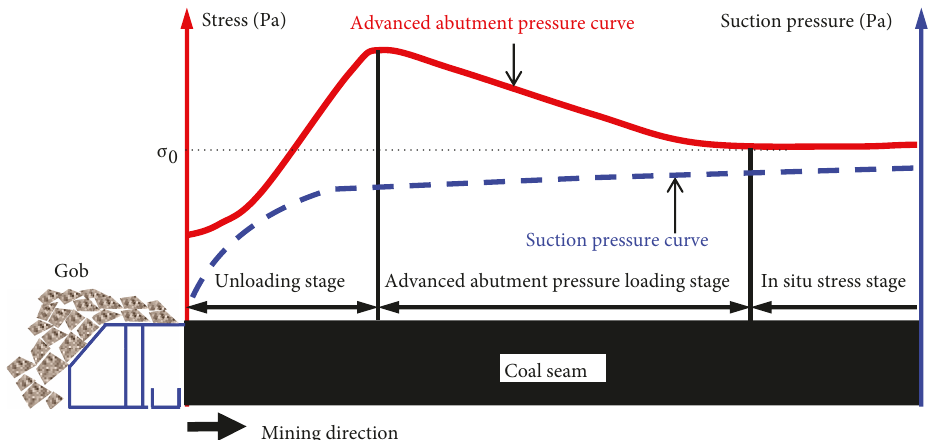
Figure 1: Variation of stress and suction pressure in front of the working